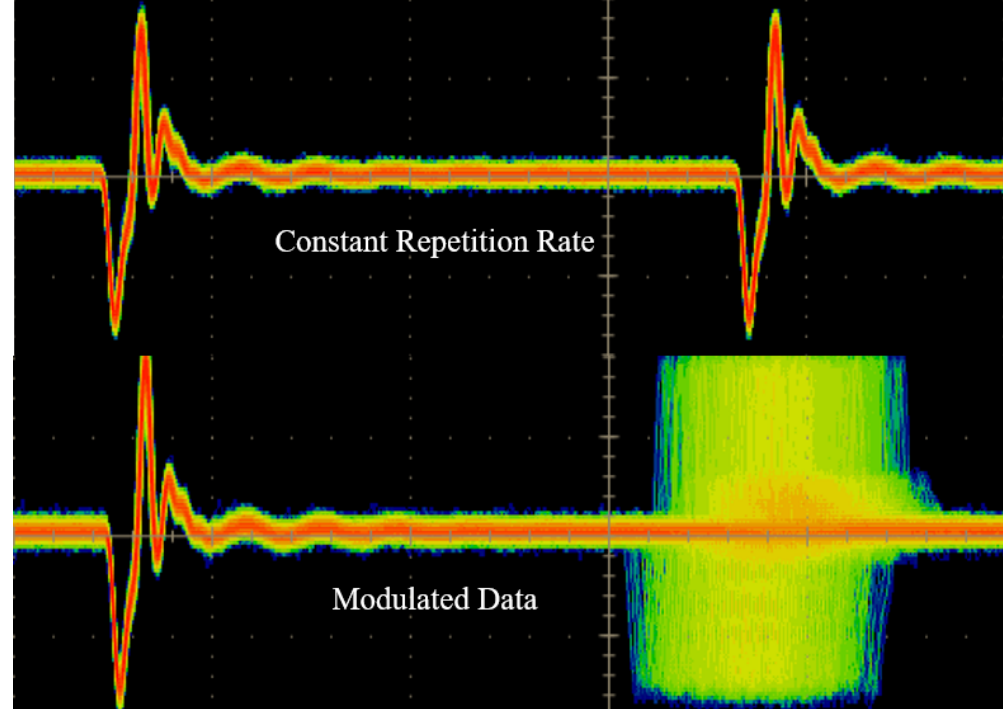
Figure 14. The oscilloscope reading is shown for the negative APD output signal. Two fast frame measurements are shown to visualize the difference between a non-modulated signal and a modulated signal. On the modulated fast frame capture, 2000 frames are shown within the single image and triggered off of a random pulse within the transmitted data. This shows the range of relative pulse positions for the data